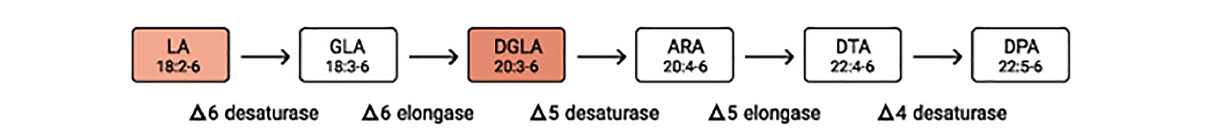
FIGURE1 Metabolic pathway of n-6 fatty acids. Since the elongation steps are quick and the desaturation steps much slower, desaturases are regarded as the rate-limiting steps. LA, linoleic acid; GLA, γ -linoleic acid; DGLA, dihomo- γ -linolenic acid; ARA, arachidonic acid; DTA, docosatetraenoic acid; DPA, docosapentaenoic acid.